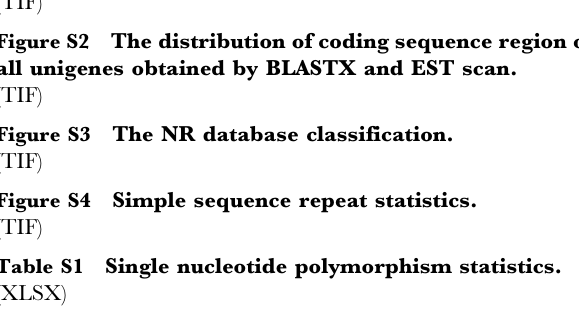
Figure S1 The length distribution of all unigenes. Figure S2 The distribution of coding sequence region of all unigenes obtained by BLASTX and EST scan. Figure S3 The NR database classification. Figure S4 Simple sequence repeat statistics. Table S1 Single nucleotide polymorphism